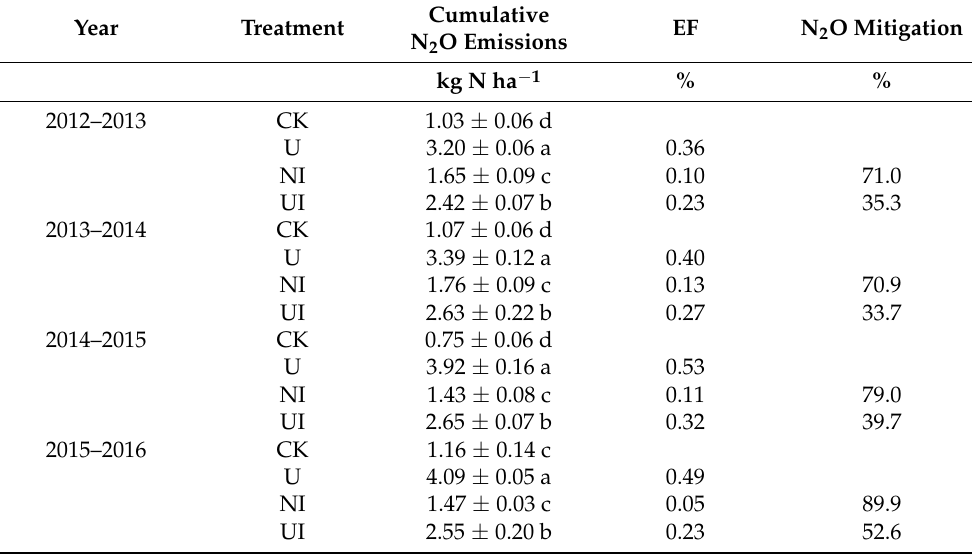
Table 1. Annual cumulative N 2 O emission factors of applied N treatments; N 2 O mitigation of DMPP and NBPT.